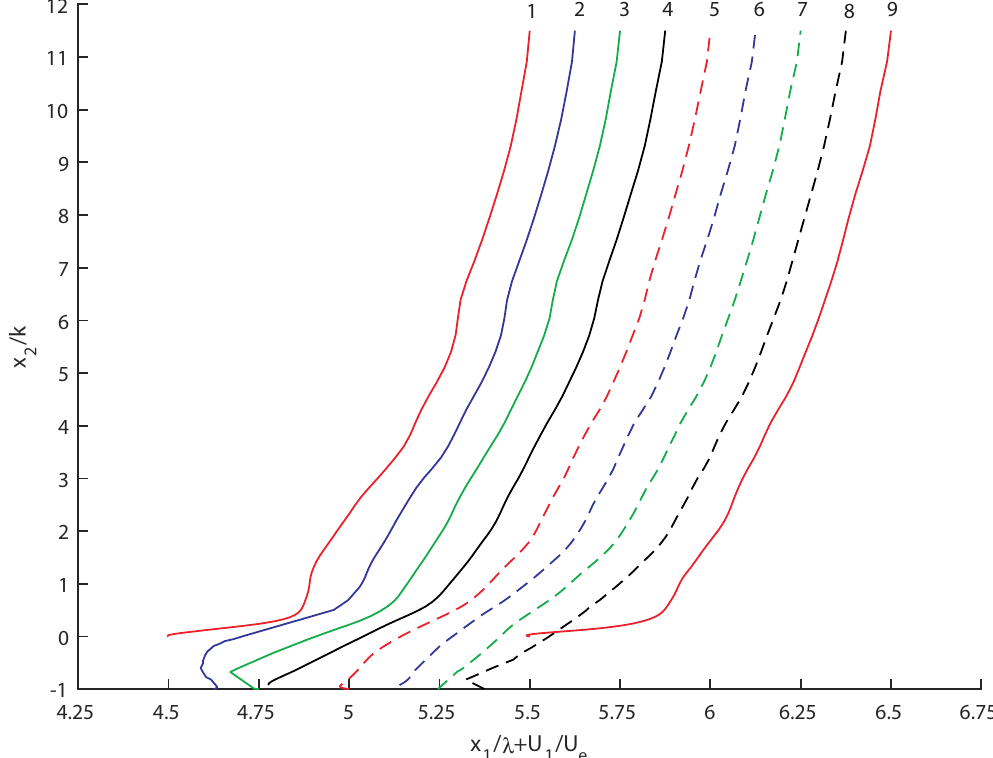
Figure 6. Vertical profiles (1, 2, ..., 9) of predicted mean-velocities U 1 for Run 4 at nine locations within a pitch ( λ ) from the 5th bar (middle) to the 6th bar (middle). The longitudinal coordinates are x 1 / λ equal to 4.5, 4.61, 4.746, 4.87, 5.0, 5.13, 5.254, 5.366, and 5.5, respectively. The average of the velocities at